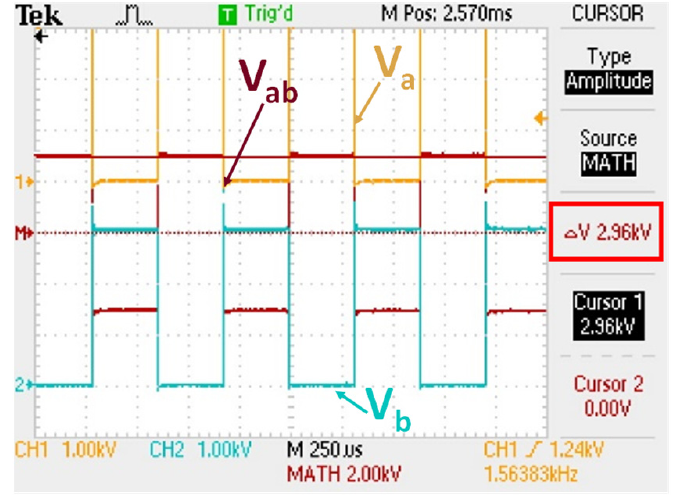
Figure 20. 2-level 3 kV peak medium-voltage inverter output.